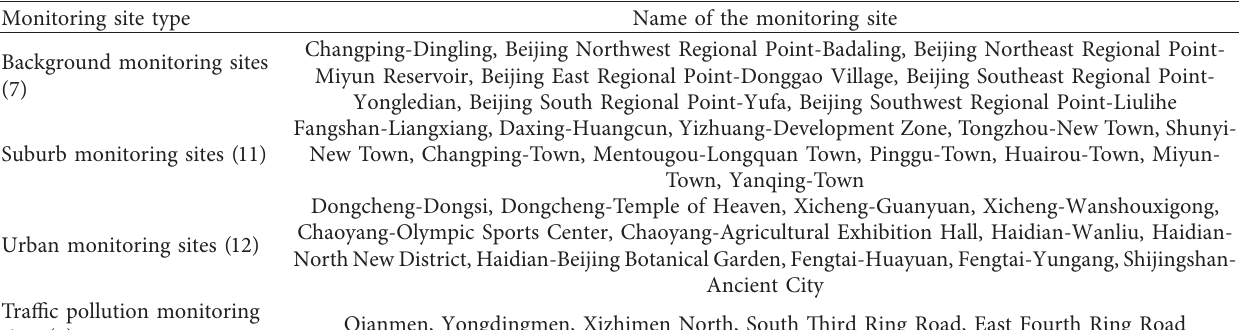
Table 3: Pollution classification according to PM